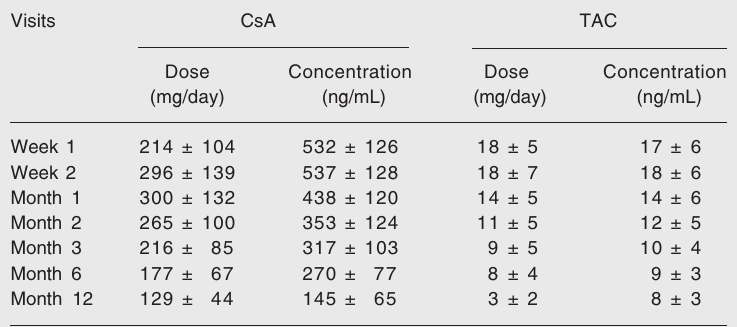
Table 2. Cyclosporine and tacrolimus doses and blood concentrations.